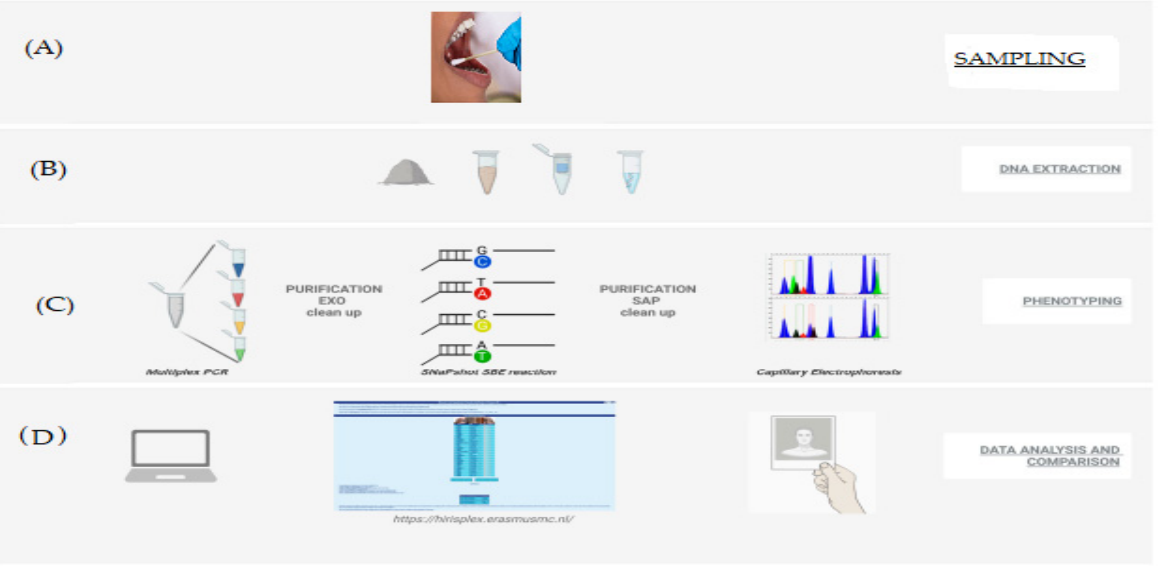
Figure 5. Illustration of the workflow for multiplex PCR phenotyping. Outlining of the main work steps, ( A ) Buccal swab sampling, ( B ) gDNA extraction, ( C ) multiplex PCR, purification of amplicons with exonuclease, SBE reactions, enzymatic purification with SAP, capillary electrophoresis, ( D ) integration of genetic data in the on-line table to obtain phenotypic results, and finally, comparison of these with the photograms of the individuals.